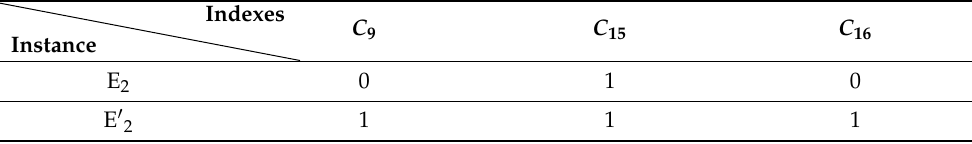
Figure 12. Values of index C 9 before and after the optimization of model E 2. Table 3. Abnormal evaluation